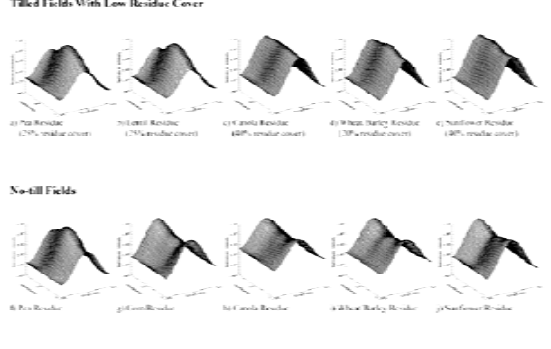
Fig 13: C-Band co-polarization signature presented in this figure are for tilled fields w residue (top) as well as for no-till fields (c been normalized to intensity values betwee et al,